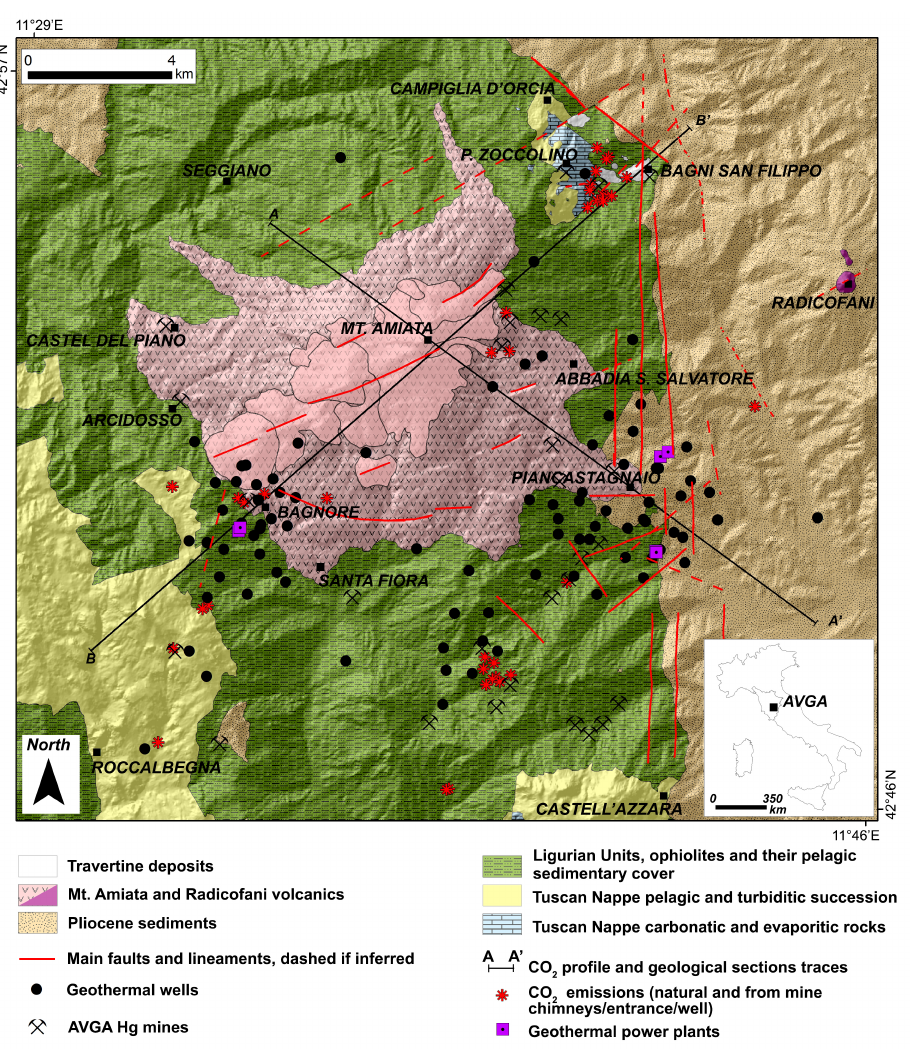
Figure 1. Geological sketch map of the Mt. Amiata volcanic–geothermal area (AVGA) area (modified from